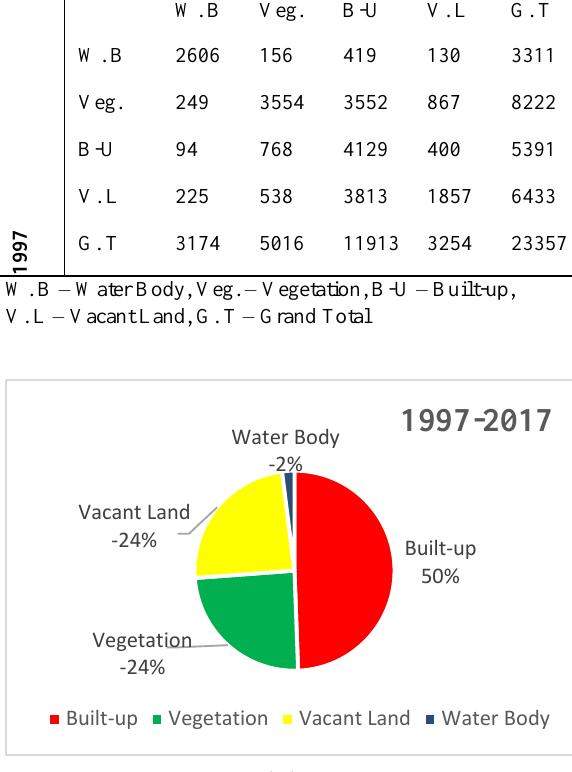
Figure 4. Areal Distribution (%) of LULC 1997-2017 LULC spatial distribution and change map for the years 1997, 2002, 2007 and 2017 is shown in figure 5.